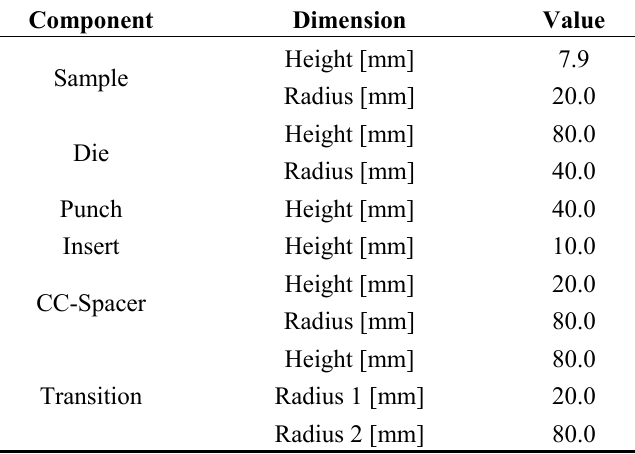
Table 1. Dimensions for Conventional 40 mm